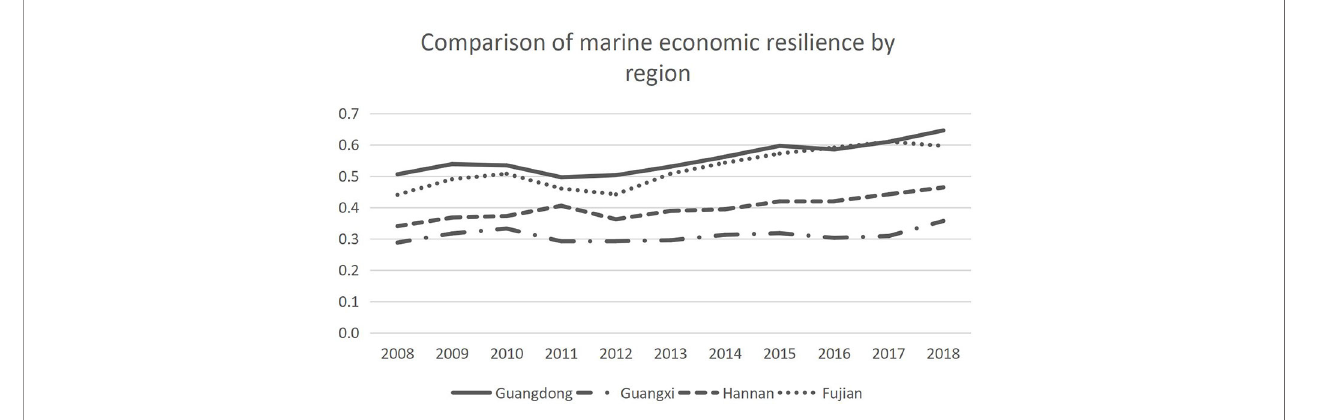
FIGURE 2 | Comparison of marine economic resilience by region in China ’ s Southern Marine Economy Circle (2008